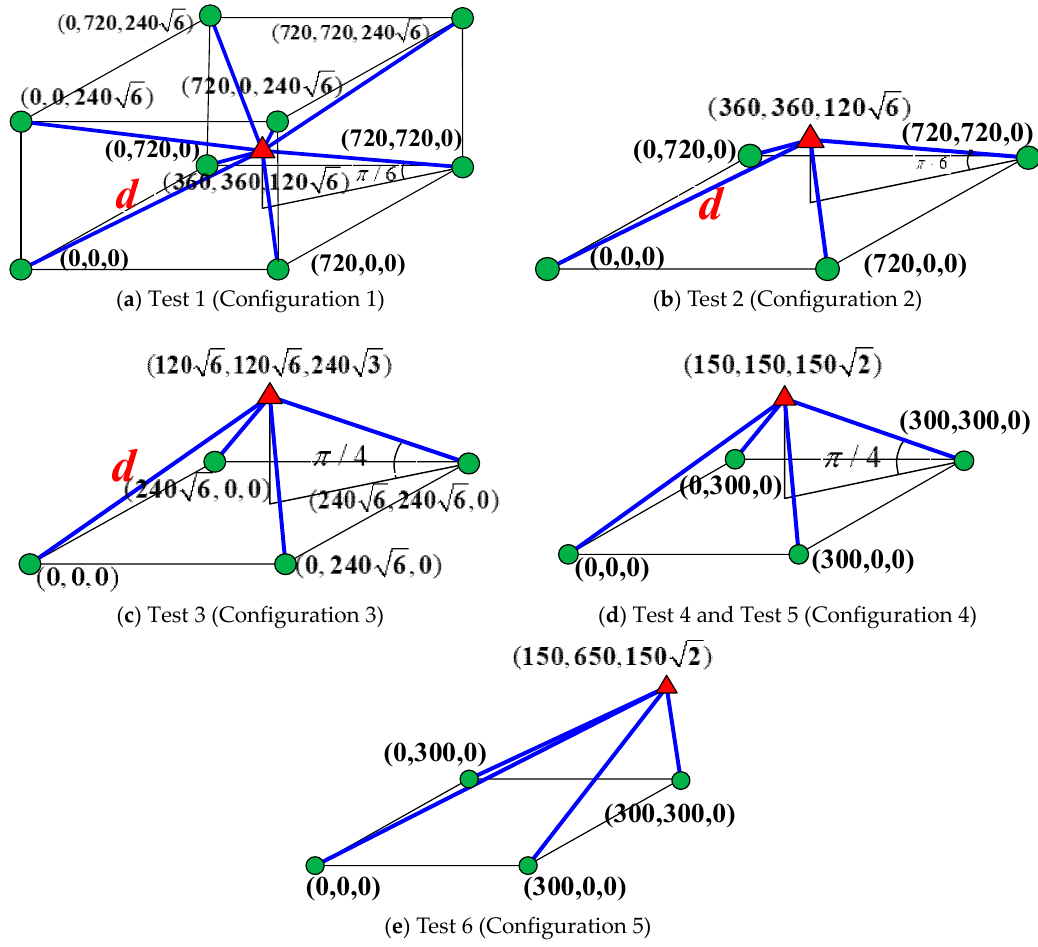
Figure 2. The tests and positioning configurations.